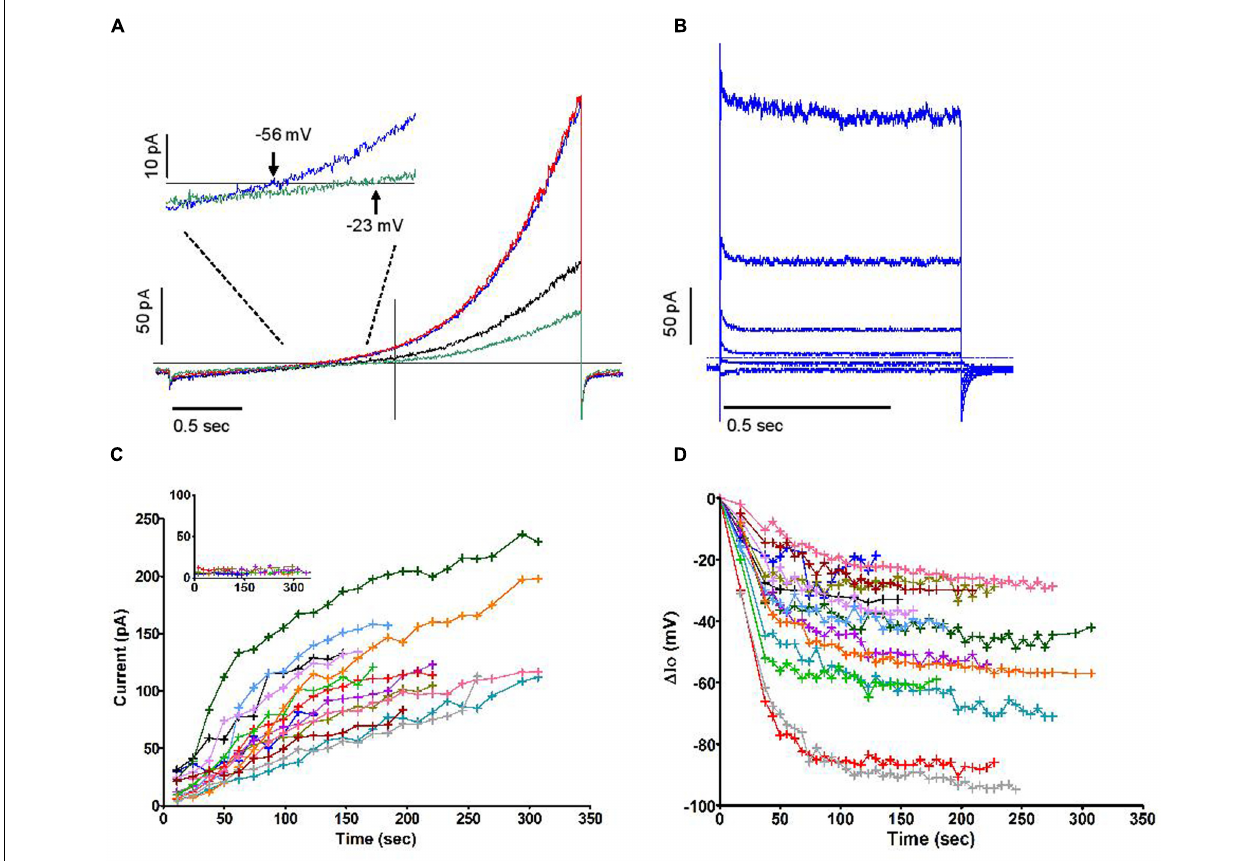
FIGURE 2 | The outward current is carried by Cl – and is insensitive to Zn 2 + . (A) Superimposed human neutrophil whole-cell currents in response to depolarising voltage ramps (from –136 to +84 mV) at 36 s (black trace) and 270 s (blue trace) after breakthrough. A steady state level of outward current was then attained which is not affected by Zn 2 + 100 µ M (red trace) but depends on external Cl – (green trace). The inset focuses on the change of reversal that accompanies the substitution of external Cl – for gluconate. (B) Superimposed responses to stepped voltage pulses (from –96 mV to –136, –76, –36, +4, +44 and +84 mV, respectively, from bottom to top traces) in control conditions after full development of the emerging outward current. (C) Time course of outwardly rectifying Cl – current increase in 14 human neutrophils at +84 mV under iso-osmotic conditions. Inset: very minimal current was recorded in perforated whole cell conditions. (D) Time course of plasma membrane hyperpolarizations ( (cid:49) I o ) in 14 human neutrophils (the same cells as C ) after the development of the outwardly rectifying Cl – current under iso-osmotic conditions. All experiments were carried out using solution set B ( Table 1